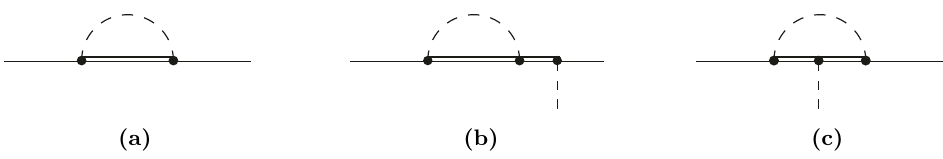
Figure 11. Diagrams contributing to dimension-six operators with two fermions. The double line denotes a mass eigenstate before EWSB. Di(cid:11)erent numbers of gauge boson lines can be inserted at any of the internal lines without a(cid:11)ecting the (cid:13)avor